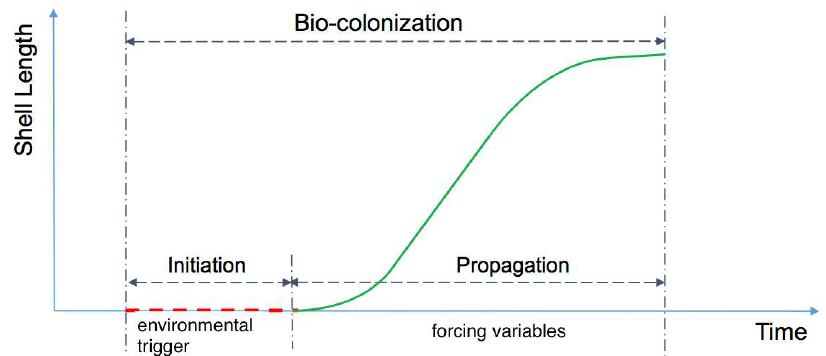
Figure 1. Schematic diagram of bio-colonization phases and their influencing parameters .